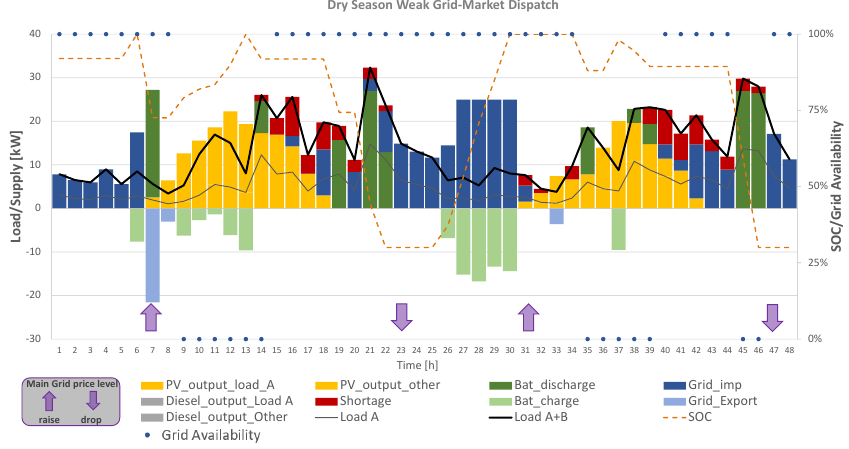
Figure 17. HOMER Pro’s CC strategy for dry season unreliable grid.